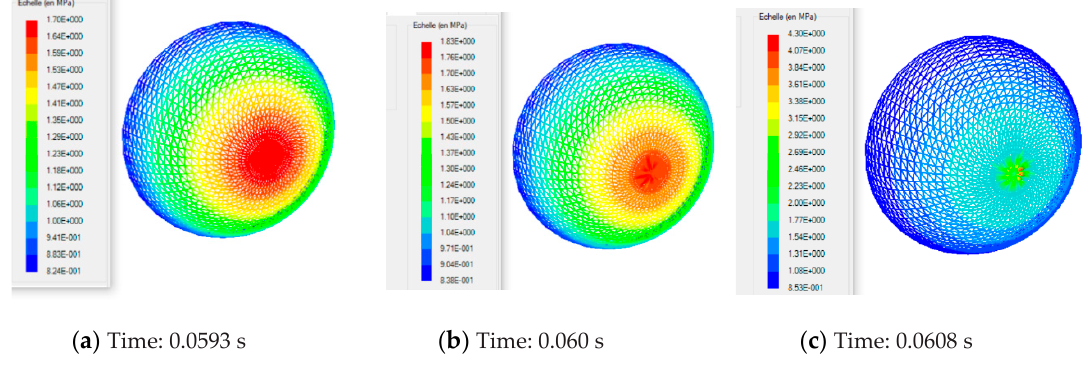
Figure 14. Von Mises constraints induced in the HDPE–PMSQ with the MD model in the time-critical